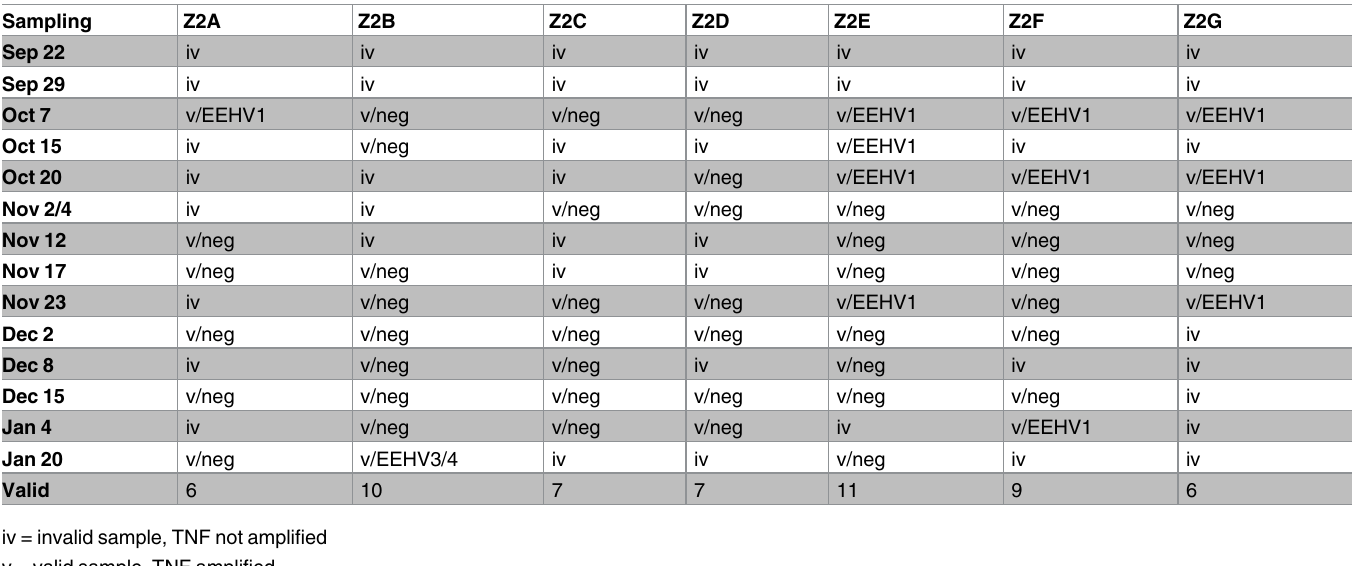
Table 3. Sampling, sample validity, EEHV